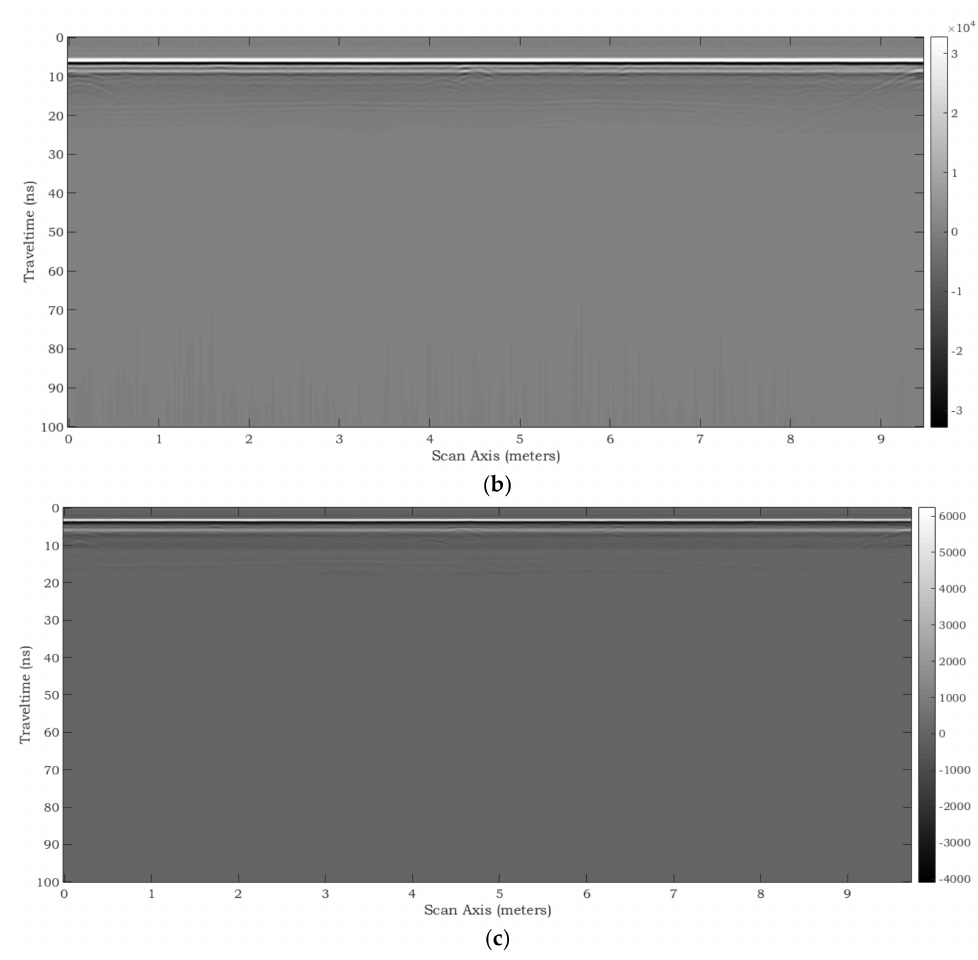
Figure 20. Profiles recorded in the silt region by using GPR 3, on a portion of acquisition line 2, with antennas operating at: ( a ) 200 MHz (9.92 m long); ( b ) 600 MHz (9.48 m long); ( c ) 900 MHz (9.72 m